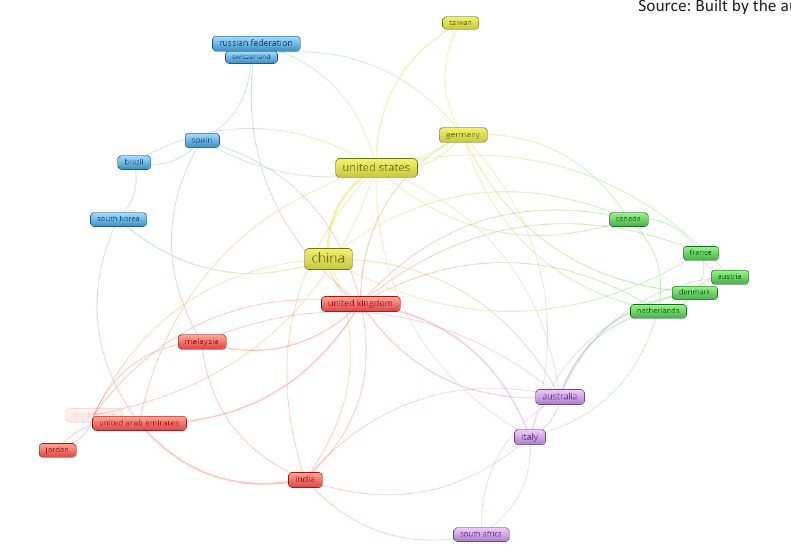
Figure 8. Visualization map of co-authorship of scientists (criterion – the country specified in the affiliation), whose general publications on blockchain AND accounting issues are